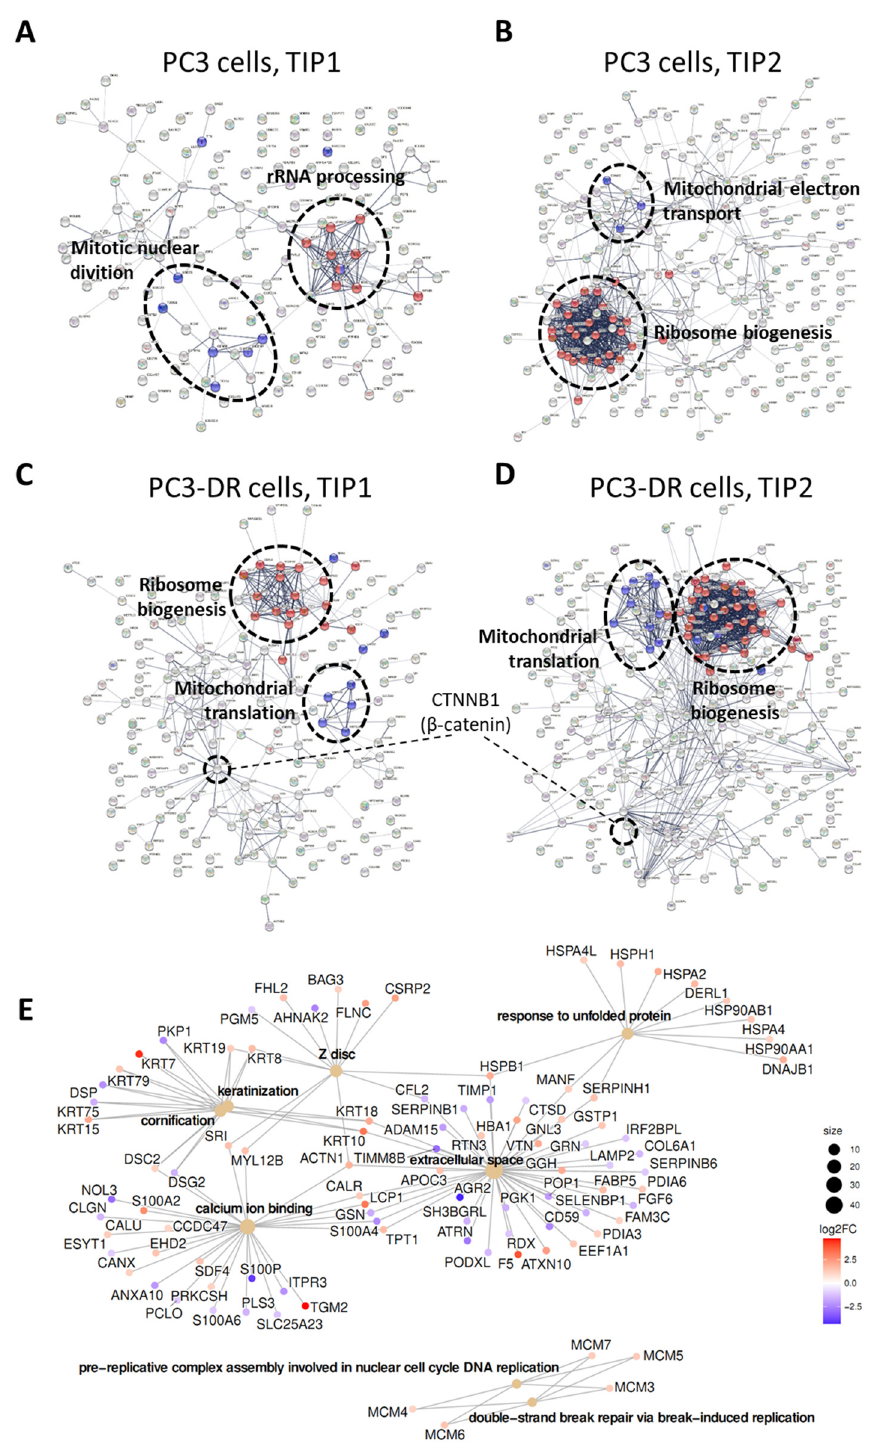
Figure 4. Protein network analysis and protein clustering. PC3 ( A , B ) or PC3-DR ( C , D ) cells were treated with TIP1 ( A , C ) or TIP2 ( B , D ) (see Materials and Methods) combination for 48 h, and the changes in proteome were identified using LC-MS/MS technique. Further functional enrichments, gene ontology, as well as the construction of the hypothetical protein interaction networks were performed using STRING v.11.5 software. The proteins used for the analysis are identical to those listed in Tables S3–S6. ( E ), Interaction network of significantly differentially expressed proteins in PC3 cells versus PC3-DR cells, both treated with TIP2 combination, that is associated with significantly enriched GO terms performed using the Molecular Signatures and the Gene Ontology databases.